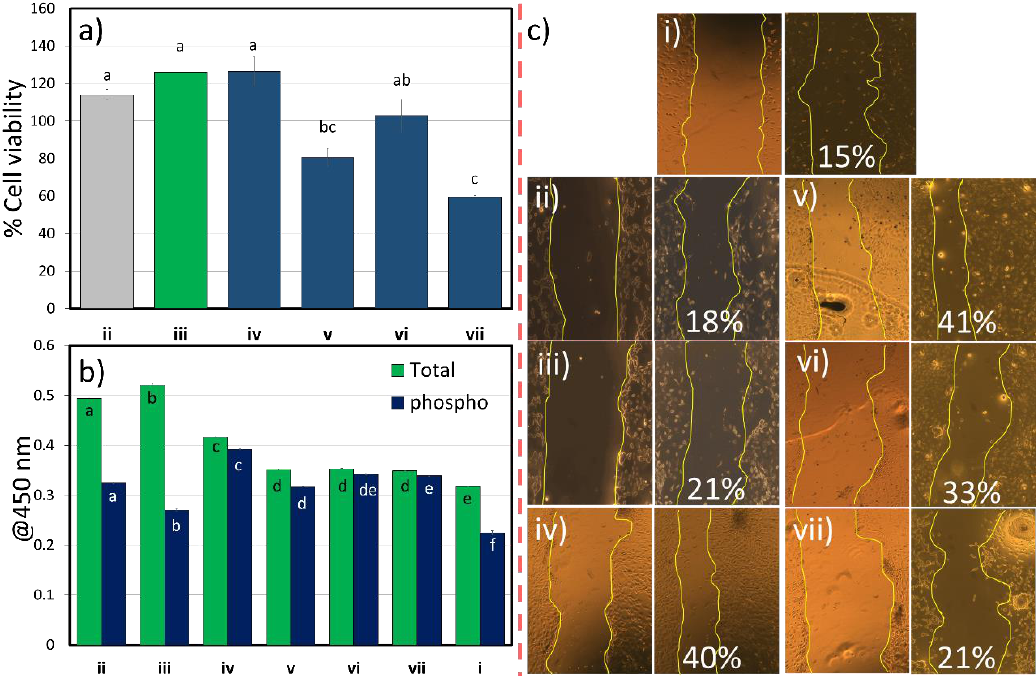
Figure 6. ( a ) Cell viability elution assay gray colour assigned to pure element (MFC), green is addition of YM10 and blue for the various samples containing YM20, ( b ) phosphorylated NF-κB p65 activity and ( c ) wound healing in vitro scratch assay at 25 mg/mL, (i) control, (ii) MFC, (iii) MFC+YM10, (iv) MFC+YM20, (v) MFC+YM20+STC, (vi) MFC+YM20+GLY, (vii) MFC+YM20+STC+GLY; same letters in each composition do not differ by Tukey’s test ( p < 0.01).